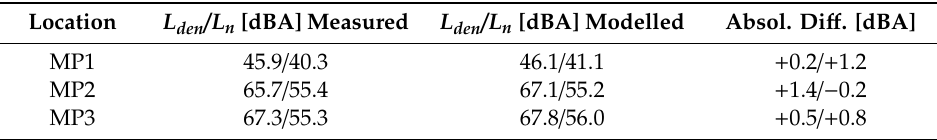
Table 2. Validation of the Guimar ã es noise map [35].